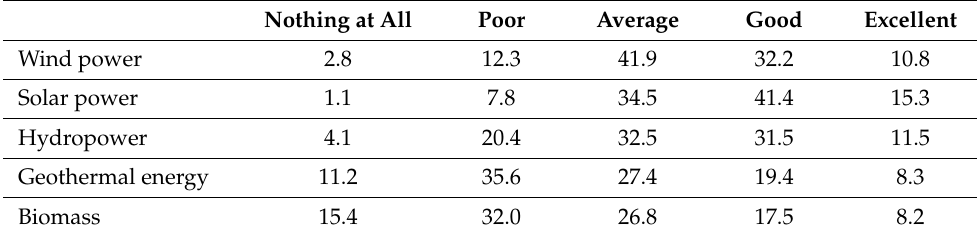
Table 2. Knowledge of respondents about RES. Nothing at All Poor